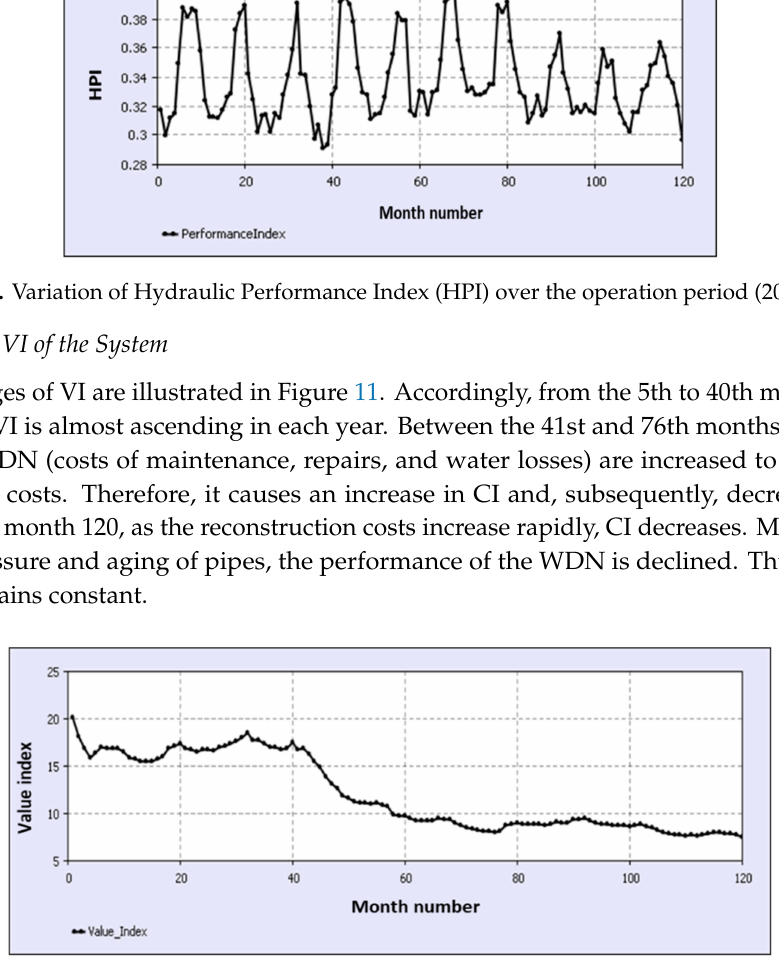
Figure 11. Variation of VI over the operation period